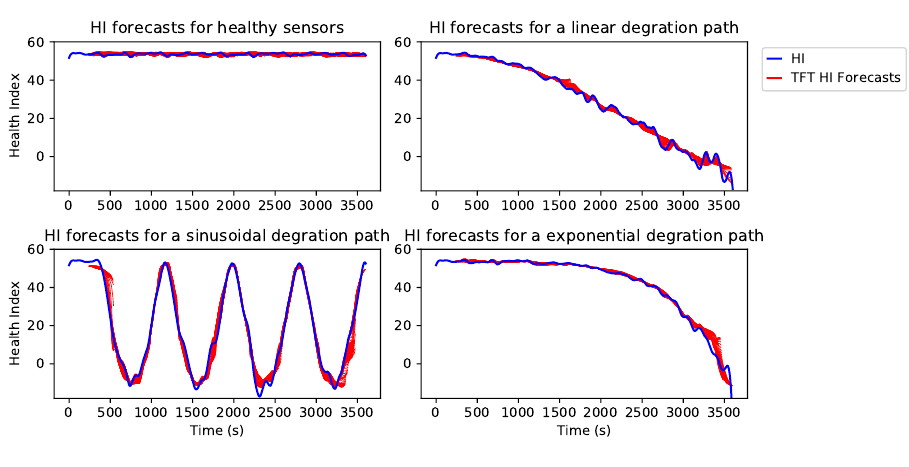
Figure 14. Test data vs. TFT predictions.